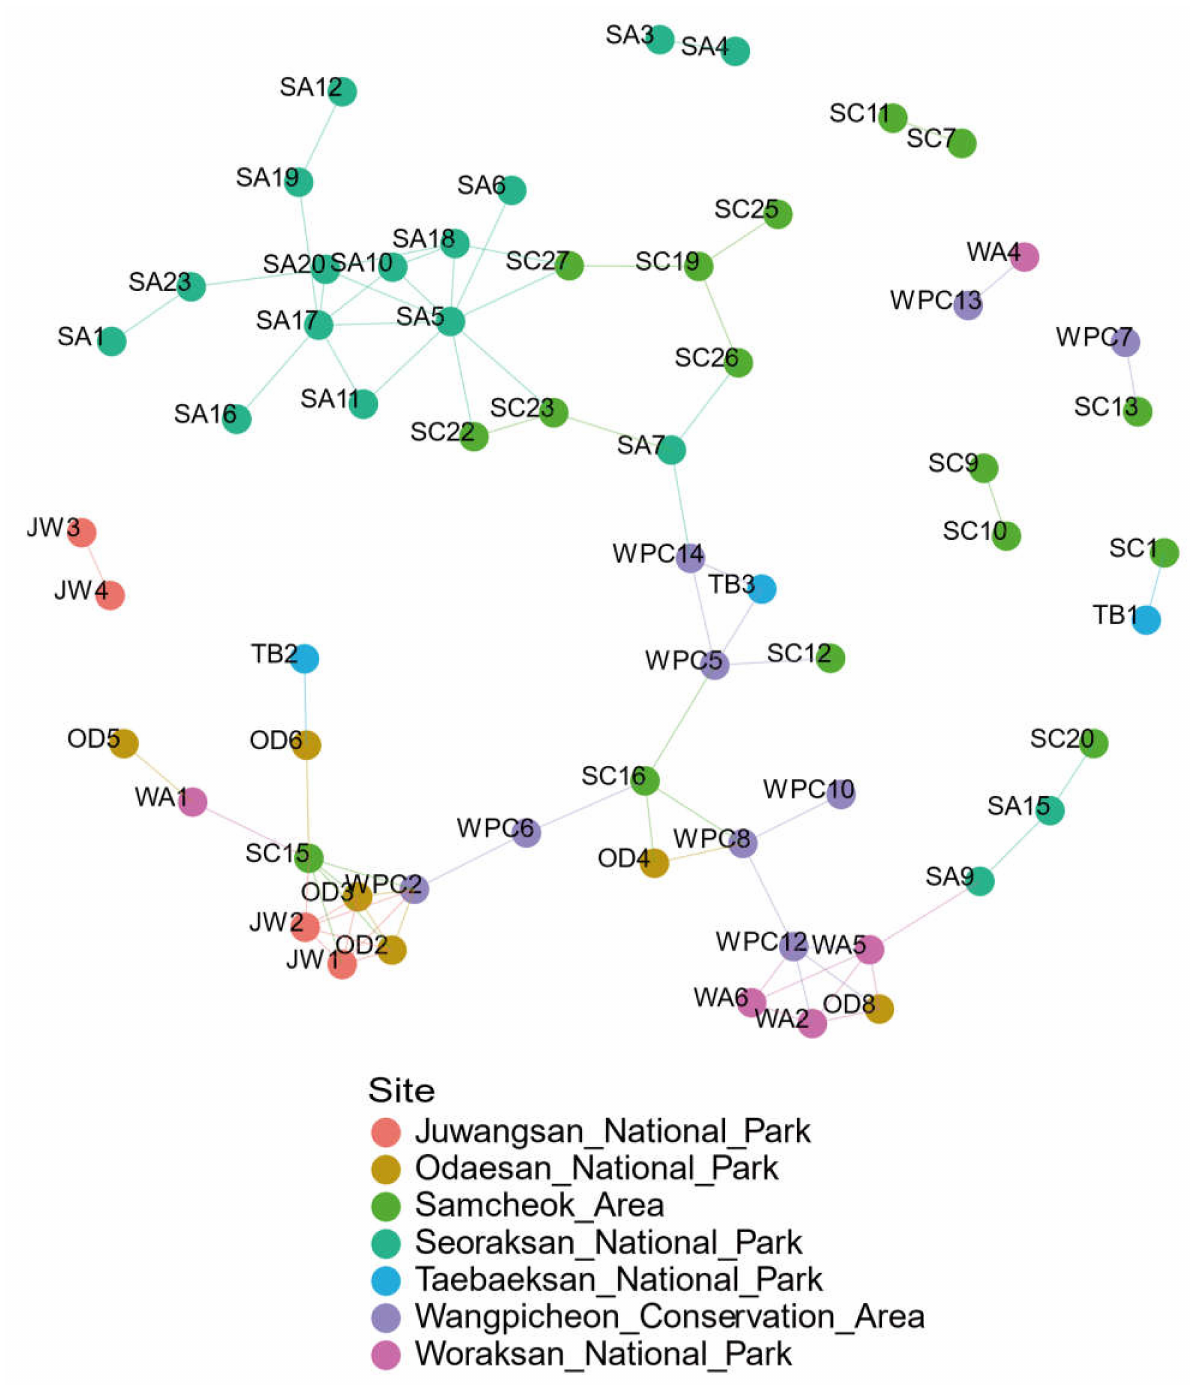
Figure 5. Site-relational network connecting long-tailed goral populations to habitat sites. Abbreviations: JW = Juwangsan National Park; OD = Odaesan National Park; SC = Samcheok Area; SA = Seoraksan National Park; TB = Taebaeksan National Park; WPC = Wangpicheon Conservation Area; WA = Woraksan National